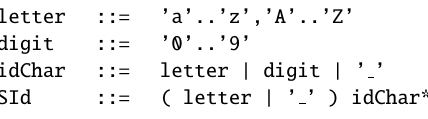
Figure 2.3: The definition of the type